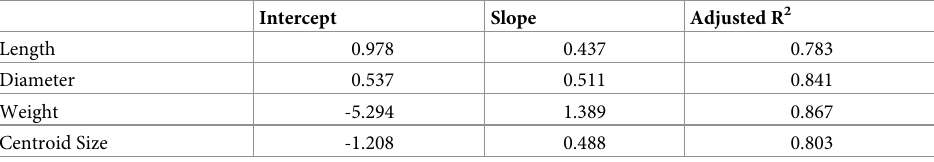
Table 5. Summary results from log-log linear regression